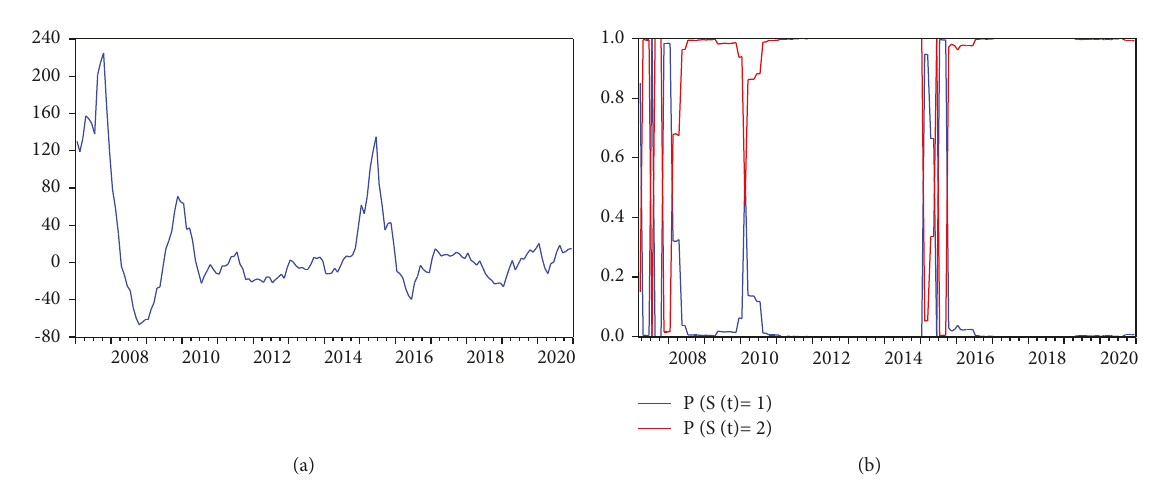
Figure 1: The volatility trend of China’s stock market (a) and the smoothing probability of its volatility state